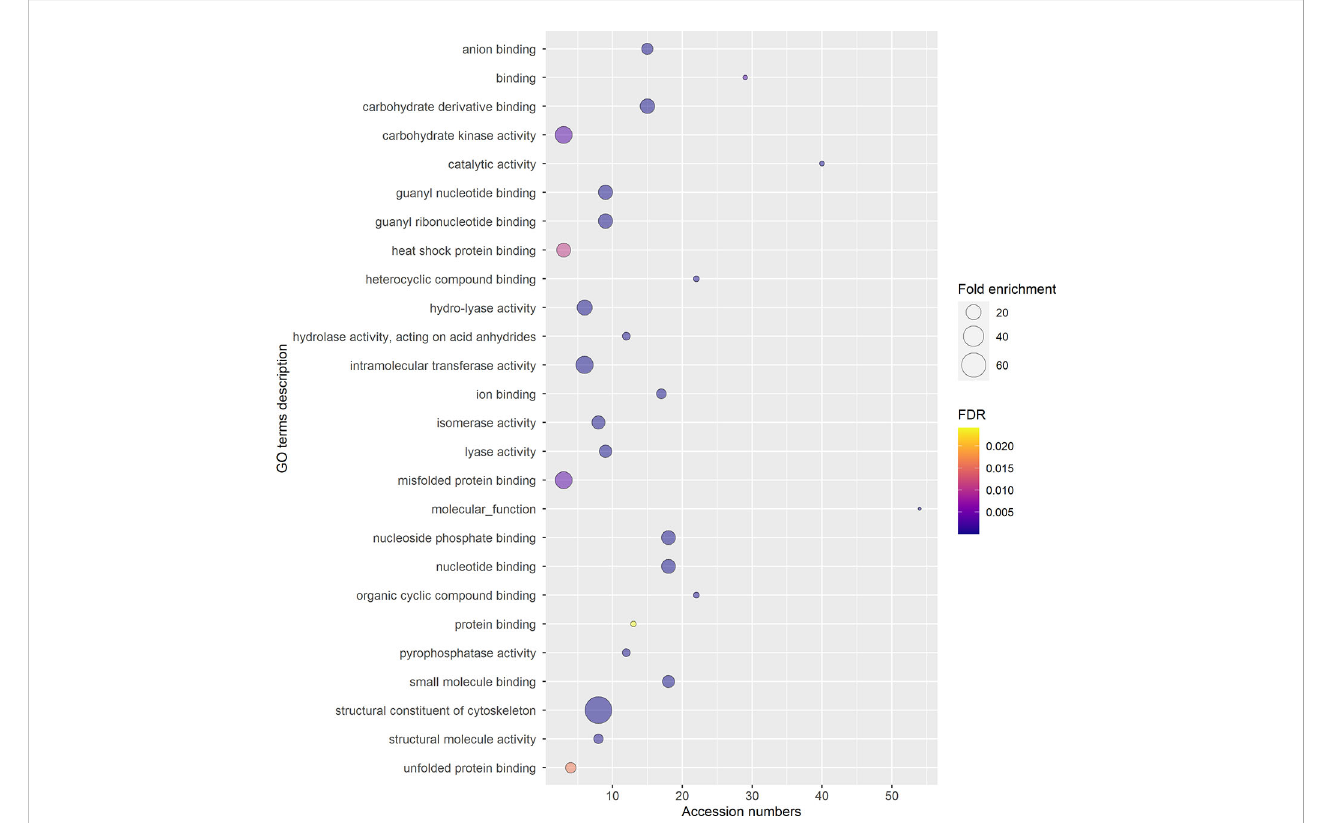
FIGURE 8 Gene Ontology (GO) terms for Molecular Functions, relative to the 97 selected accession numbers identi fi ed in extracellular nanovesicles from germinated pollen of Actinidia chinensis Planch. GO terms were provided by Panther Classi fi cation System version 17.0 and shortened by REVIGO using SimRel similarity measure. The diameter of the bubbles indicates the overrepresentation of the term when compared to the whole Actinidia chinensis Planch. genome (Fold enrichment), while the color indicates the False Detection Rate (FDR) value. GO terms with FDR>0.05 are not